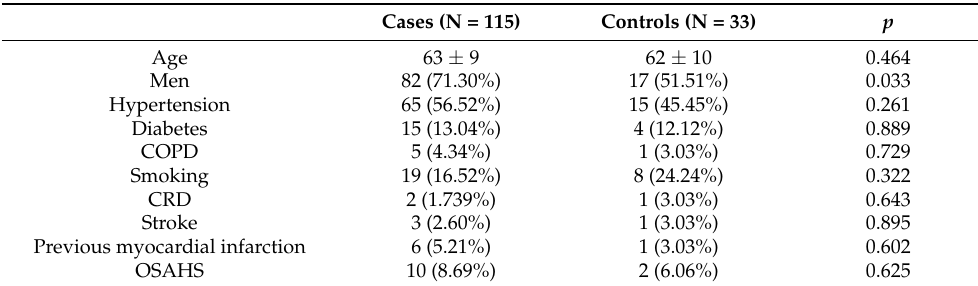
Table 1. Clinical differences between cases and